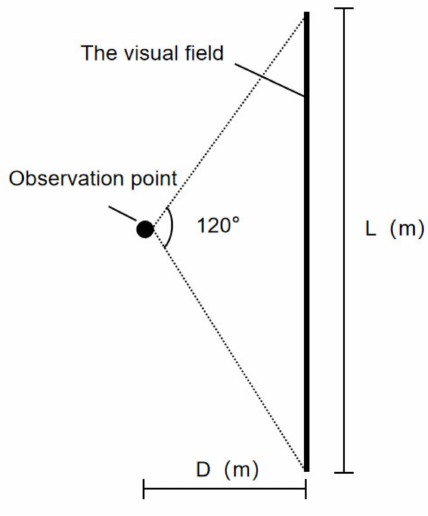
Figure 4. The field of view for horizontal view. Table 2. Skyline hierarchical classification.